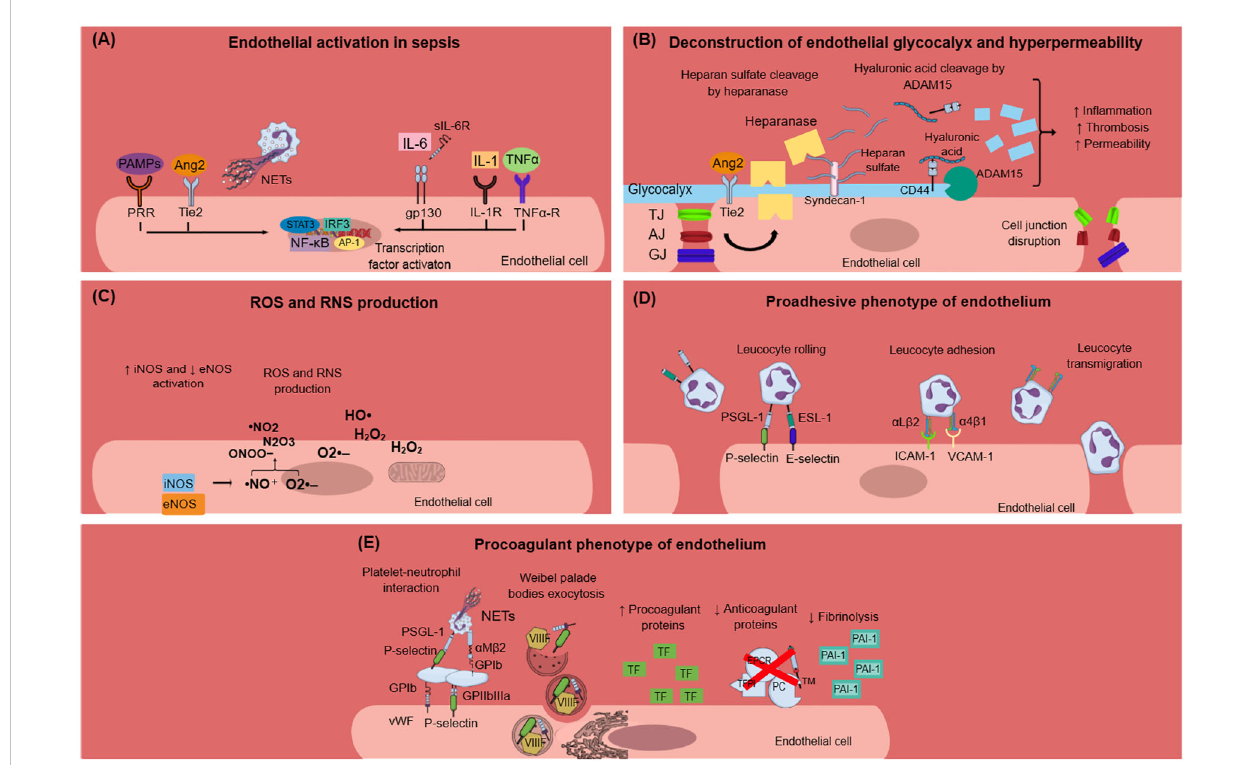
FIGURE 1 Endothelial dysfunction in sepsis. (A) PAMPs, TNF- a , IL-1, IL-6, Ang2, and NETs activate endothelial cells during sepsis. This results in intracellular signaling activation, leading to transcription factors activation, and mainly NF- k B. (B) Endothelial glycocalyx damage during sepsis is mediated through heparanase and ADAM15, which cleave heparan sulfate and CD44, respectively. Glycocalyx deconstruction results in increased in fl ammation, thrombosis, and hyperpermeability in sepsis. Furthermore, sepsis leads to endothelial cell junctions ’ disruption, which subsequently leads to increased endothelial permeability. (C) Sepsis is characterized by dysregulated nitric oxide synthase activation, leading to the production of reactive nitrogen species. Moreover, infection triggers endothelial cells to produce ROS, which in turn destroy the endothelium. (D) Endothelium activation during sepsis results in the expression of E-selectin, P-selectin, VCAM-1, and ICAM-1 on the endothelial cell surface and subsequent leukocyte rolling, adhesion, and transmigration through endothelial cells. Leukocytes express speci fi c ligands for binding with endothelial receptors such as PSGL-1 and ESL-1 for leukocyte rolling and a L b 2 and a 4 b 1 integrins for leucocyte adhesion. (E) Activated endothelial cells during sepsis express molecules such as vWF and P-selectin on their surface, which mediate platelet aggregation. This leads to the formation of platelet- neutrophil aggregates and subsequent neutrophil activation. Weibel – Palade bodies contain procoagulant factors such as VIIIF, vWF, and P-selectin that can undergo exocytosis under sepsis conditions. The procoagulant phenotype of the endothelium is further characterized by increased production of TF and subsequent extrinsic coagulation pathway activation, decreased production of anticoagulant proteins (TFPI, EPCR, TM, PC), and increased production of PAI-1, which inhibits fi brinolysis. Ang2, angiopoietin 2; ADAM-15; disintegrin and metalloproteinase 15; AJ, adherens